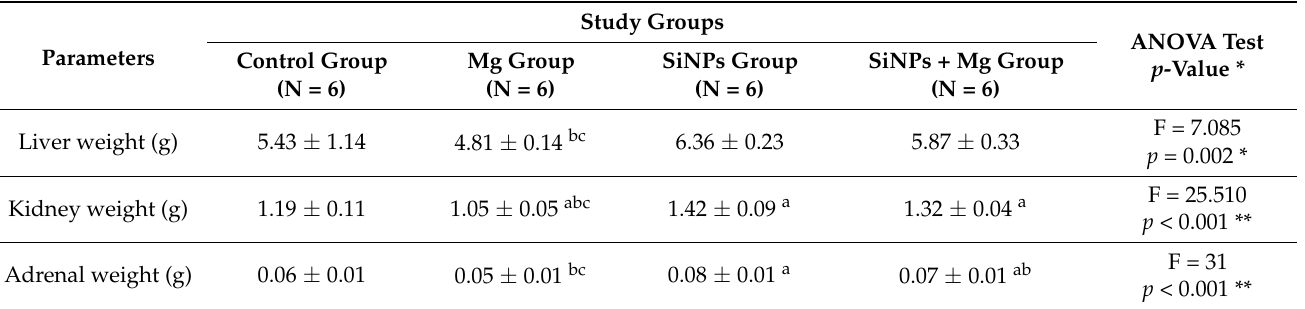
Table 6. Comparison between the studied groups regarding the weight of theliver, kidneys, and adrenal glands in the studied